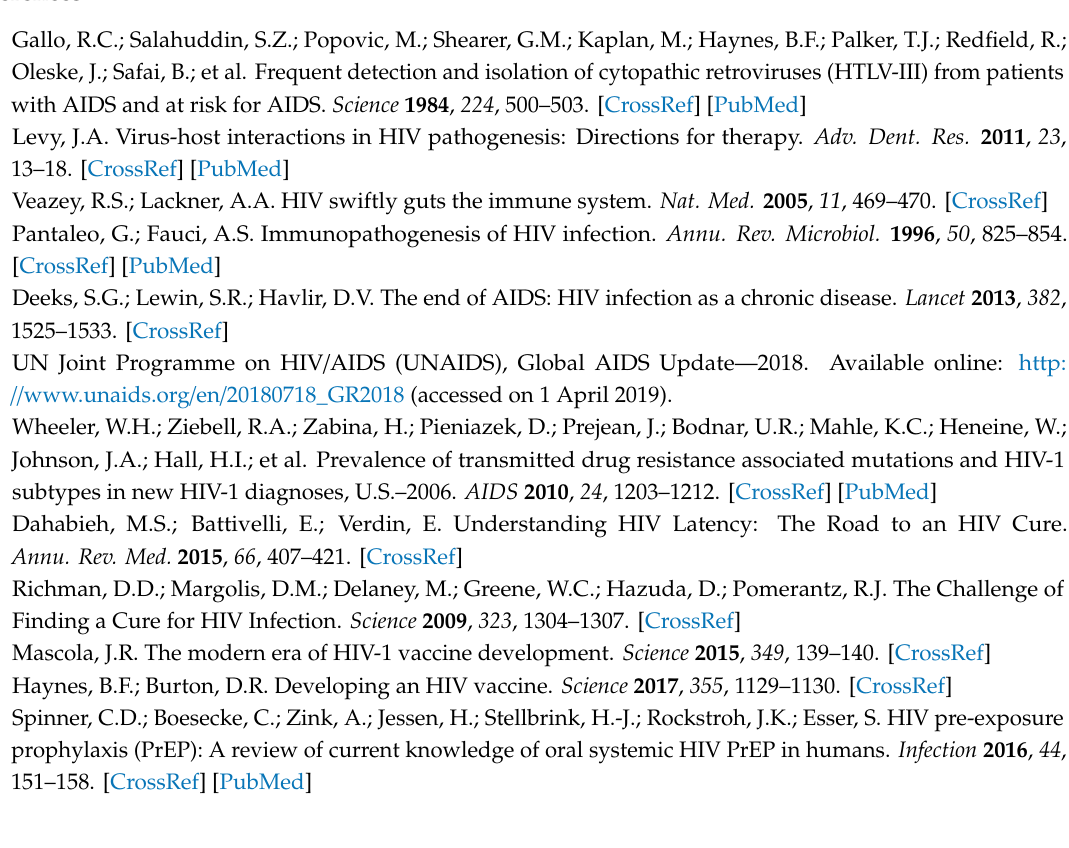
Figure S1: Avirulin chemical structures, Table S1: Avirulin chemical